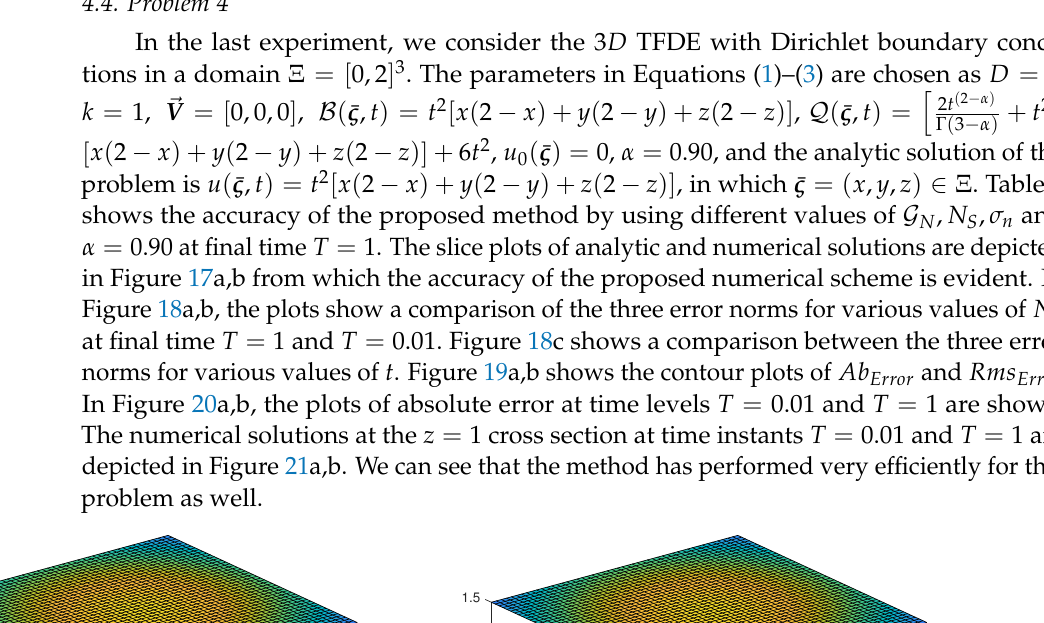
Table 4: The errors obtained using proposed scheme at final time T = 1 for problem 4 Figure 16: (a) Contour plot of Ab Error at time level T = 1 . (b) Contour plot of Rms Error at time level T = 1 . Figure 16. ( a ) Contour plot of Ab Error at time level T = 1. ( b ) Contour plot of Rms Error at time level T = 1. α = 0 . 9